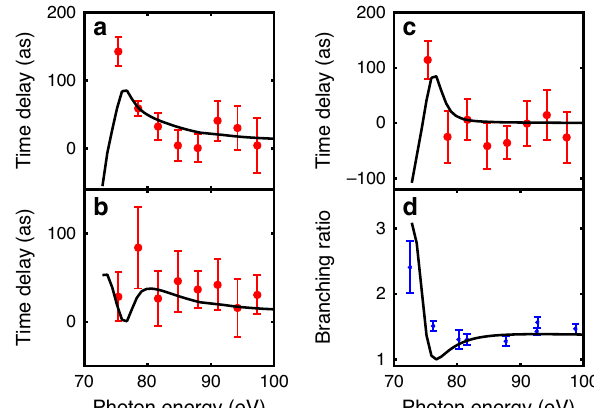
Fig. 3 Atomic time delays and branching ratio. Absolute atomic time delays for a 4 d 3/2 and b 4 d 5/2 ; c Difference between these delays. The experimental data are given in red dots. The black lines indicate the results of two-photon RRPA calculations. The estimation of the error bars is the standard error of the weighted mean, detailed in Methods section. In d , the calculated branching ratio of the 4 d 5/2 over 4 d 3/2 cross sections is shown in black. The experimental data in blue dots is from ref. 37